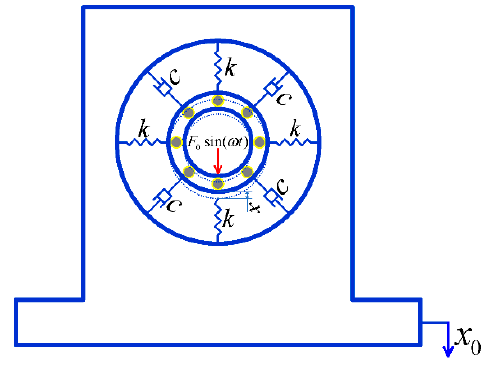
Figure 2. Vibration isolation model.